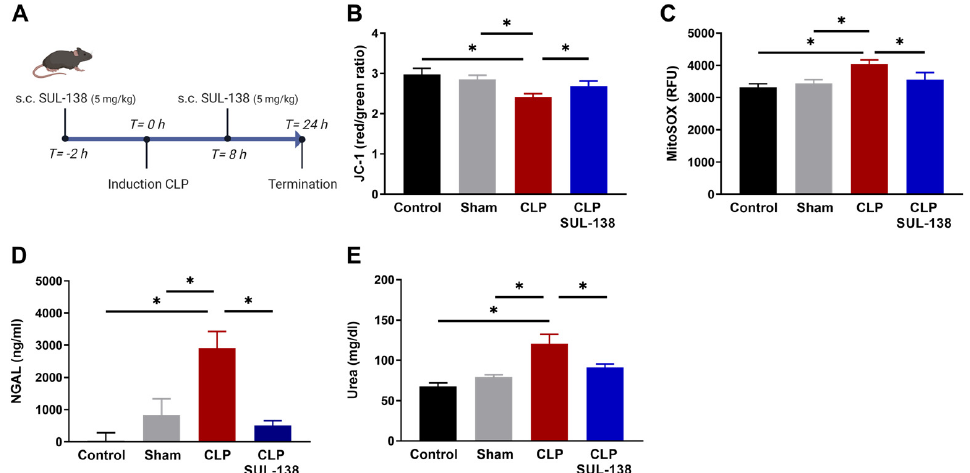
Figure 3. SUL-138 counteracted CLP-induced mitochondrial and kidney dysfunction in mice. ( A )